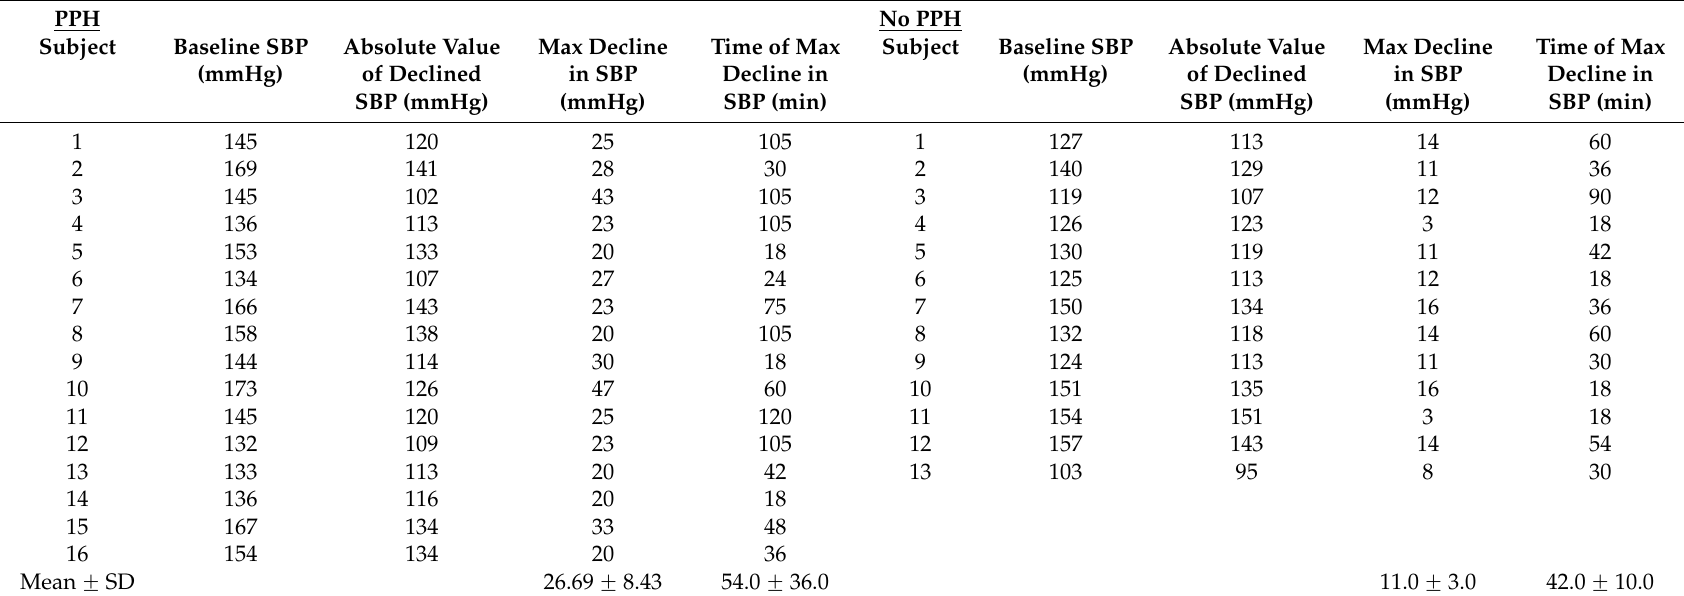
Table 1. Absolute value of declined SBP, and maximum decline and time of maximum decline in SBP following oral glucose (50